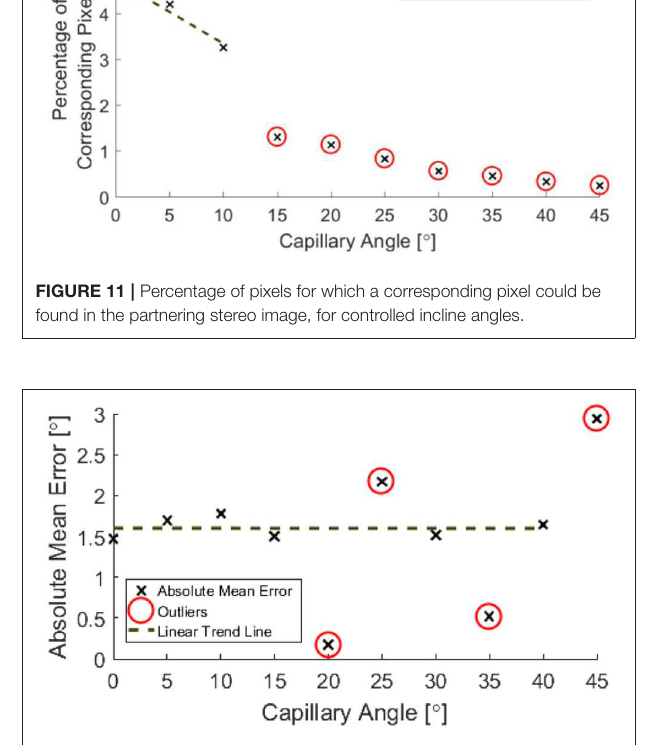
FIGURE 12 | Absolute mean error in phantom angle against controlled angle.